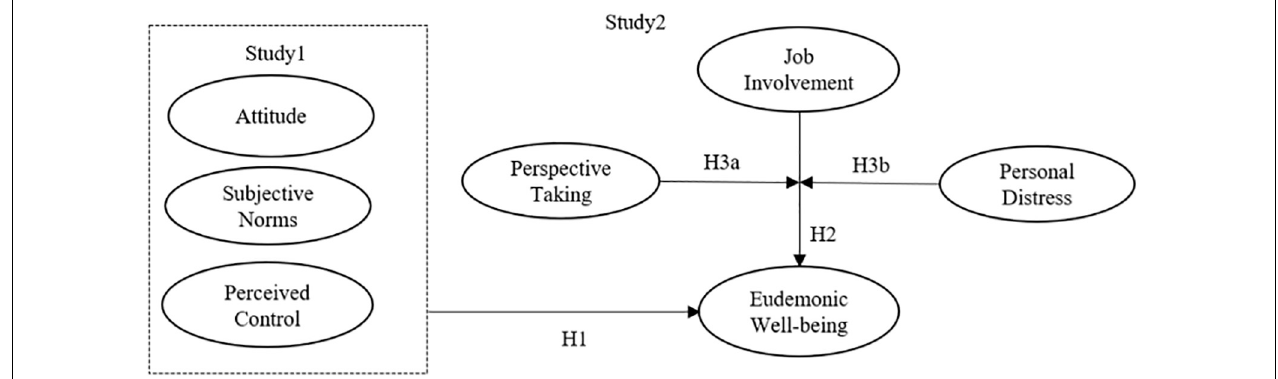
FIGURE 1 | Research model. Source: